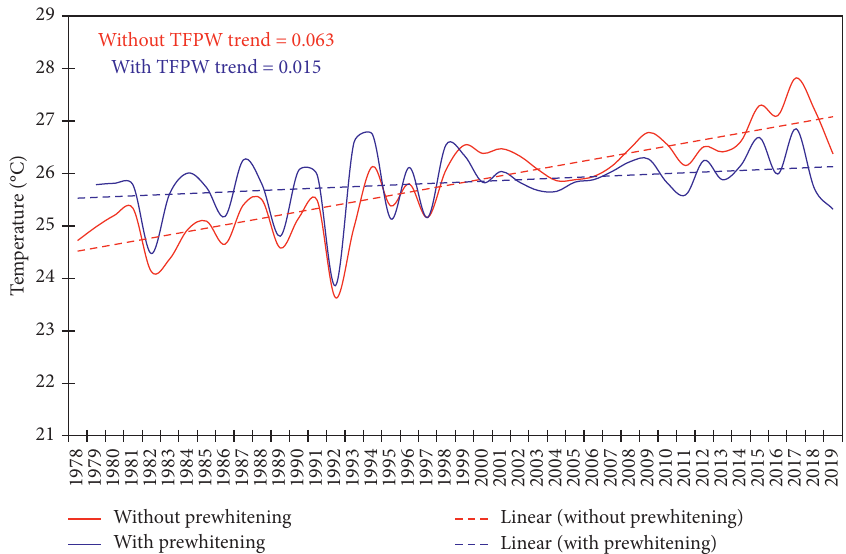
Figure 3: Annual mean temperature for station Abha in Saudi Arabia for the period 1978–2019. The red and blue solid lines represent, respectively, with, and without, trend-free prewhitening (TFPW) applied in the linear trend calculation. The dashed lines represent the linear trends in the corresponding time series.